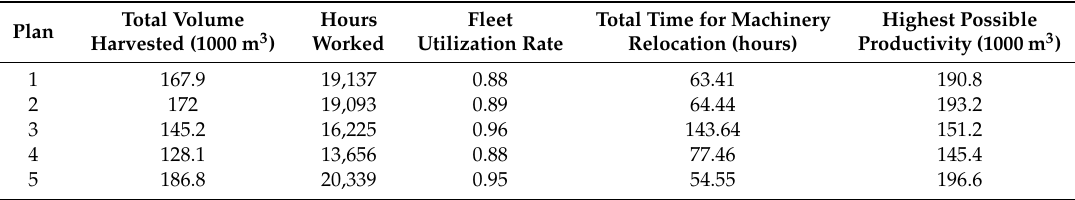
Table 3. Machinery utilization.